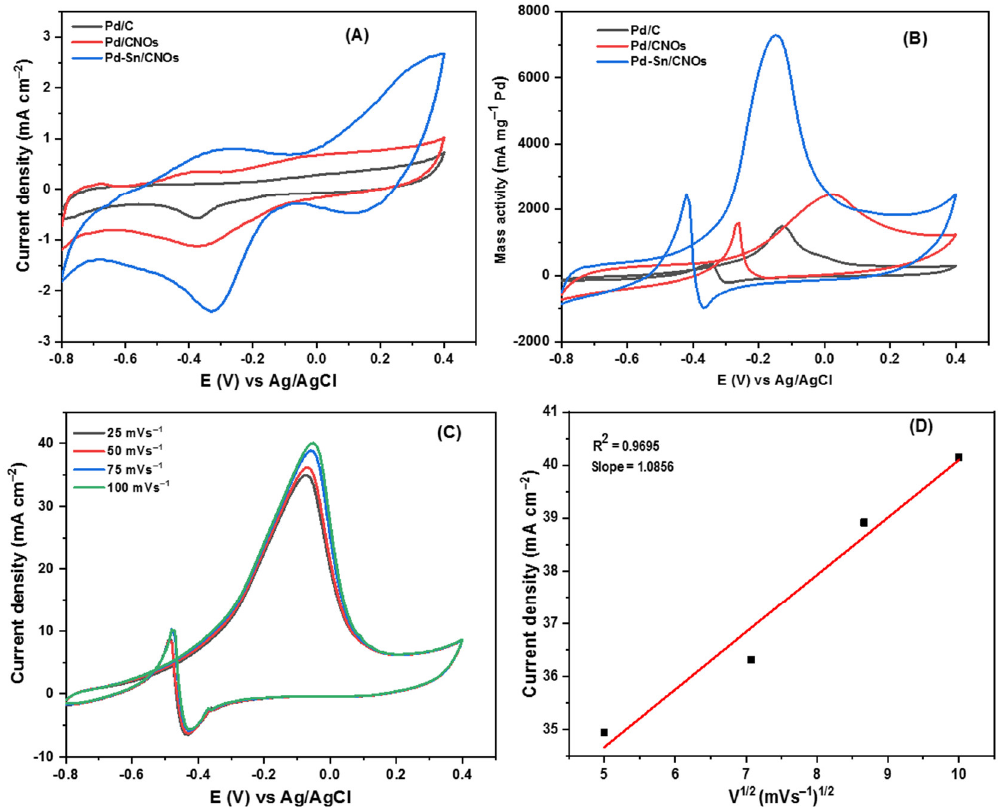
Figure 7. ( A – D ) Cyclic voltammogram of Pd/C, Pd/CNOs, and Pd-Sn/CNOs in 1 M KOH ( A ) and in 1 M KOH + 1 M CH 3 OH ( B ) solution at a scan rate of 50 mVs − 1 at room temperature. Cyclic voltammogram of Pd-Sn/CNO electro-catalyst in 1 M KOH + 1 M CH 3 OH at different scan rates ( C ) and the plot of peak current density vs. square root of scan rates ( D ).